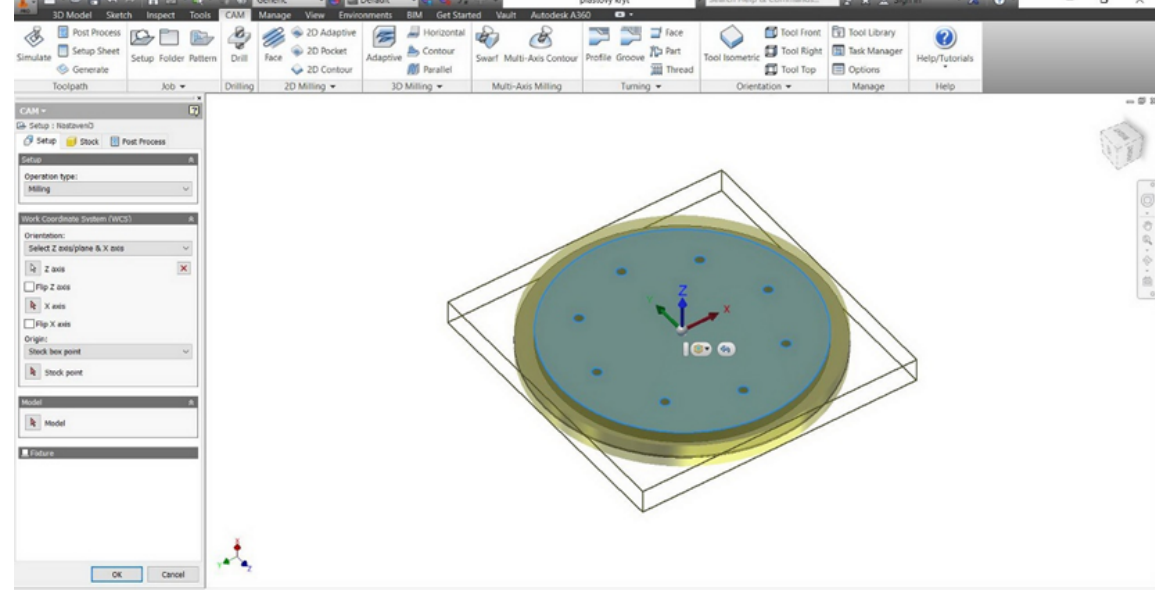
Figure 9: Simulation of drilling holes for threaded surfaces.